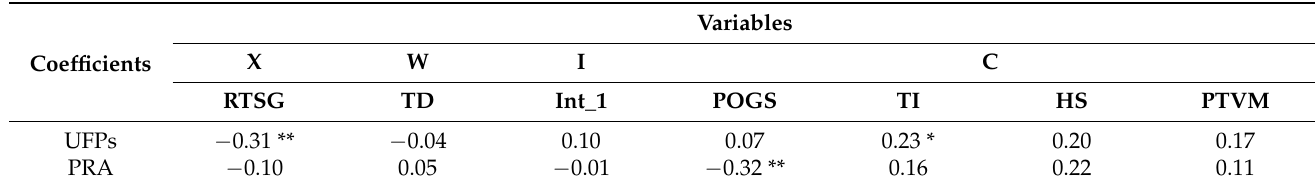
Table 3. Coefficients of variables (outcome variable: Mediators).